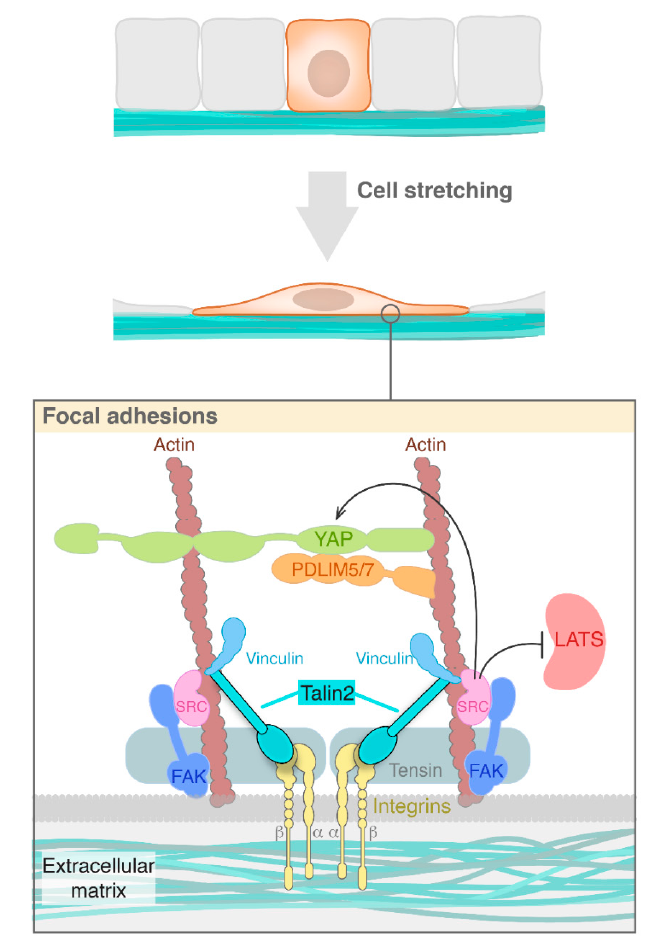
Figure 1. The regulation of YAP at the level of the extracellular matrix involves various proteins involved in stabilizing and activating YAP. Integrins sense the external forces and transmit this signal to talin family members which allow YAP and accessory proteins to act as mechanosensors within the cell